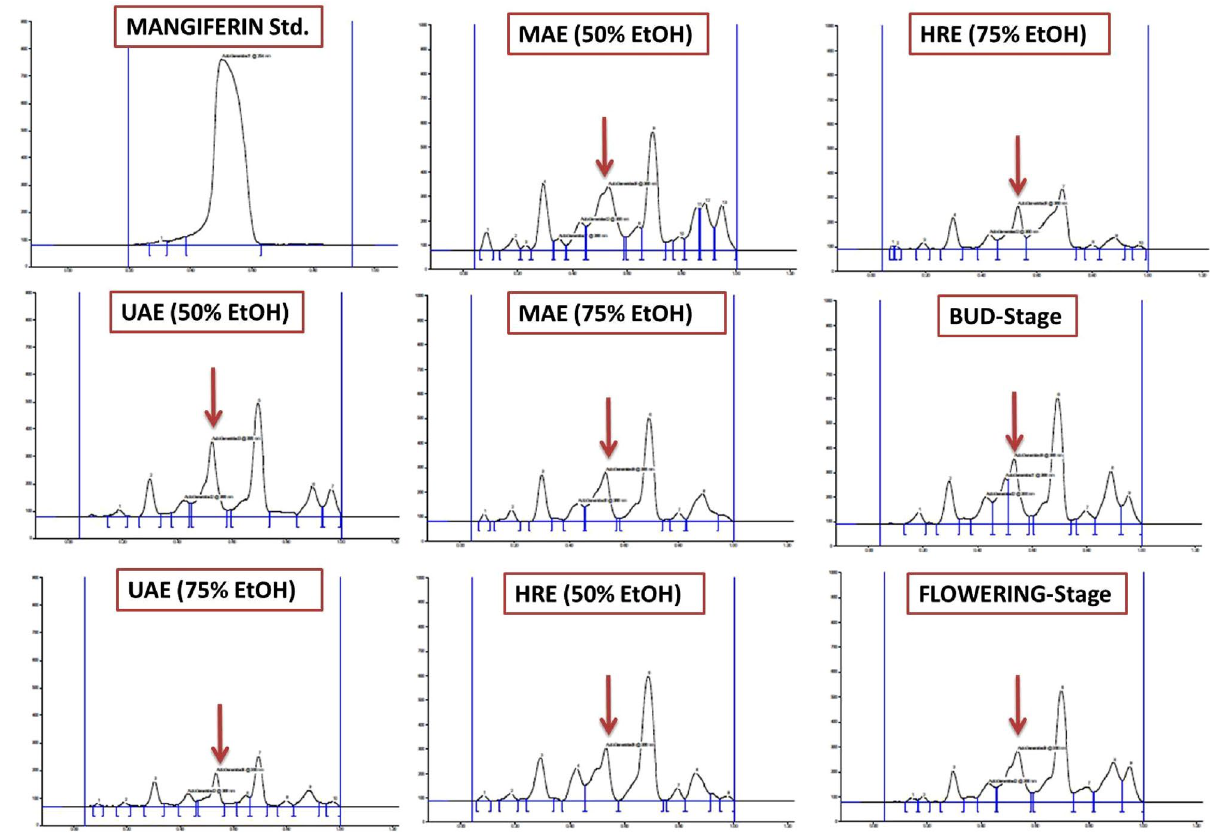
Figure 5. Densitometric-HPTLC chromatograms of S. chirata demonstrating effect of extraction methods viz. ultrasound-assisted extraction—UAE, microwave-assisted extraction—MAE, heat-reflux extraction—HRE and stage of plant on mangiferin